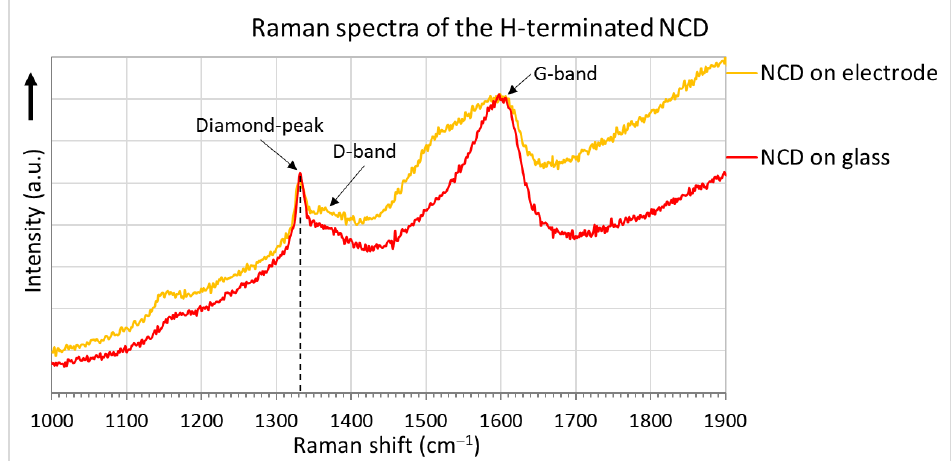
Figure 7. Raman spectra of the NCD layers.